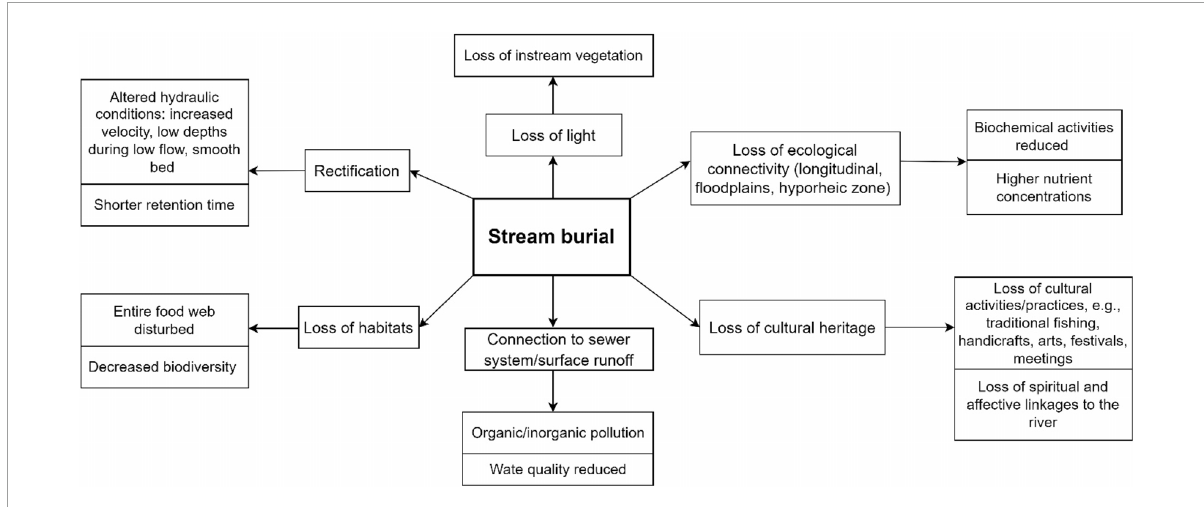
FIGURE1 A synthesis of impacts caused by stream burial. See text for